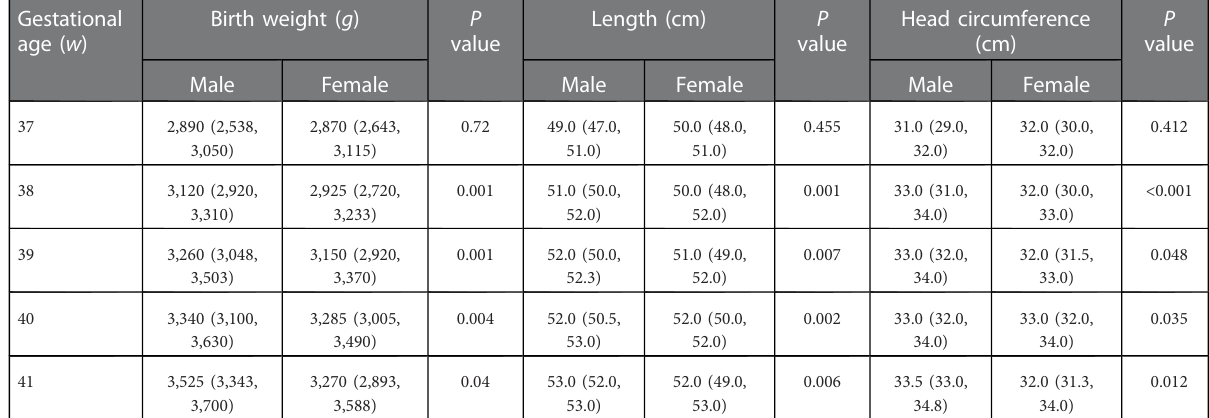
TABLE 2 Distribution range of growth and development indicators by gender and gestational age.